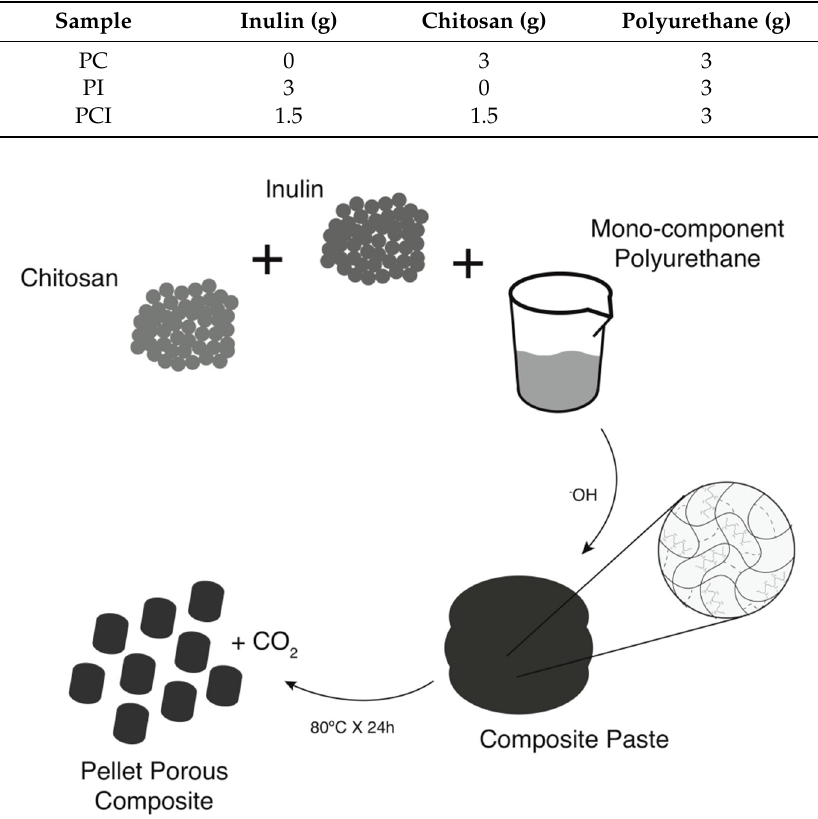
Table 2. Components ratios for each blend prepared.